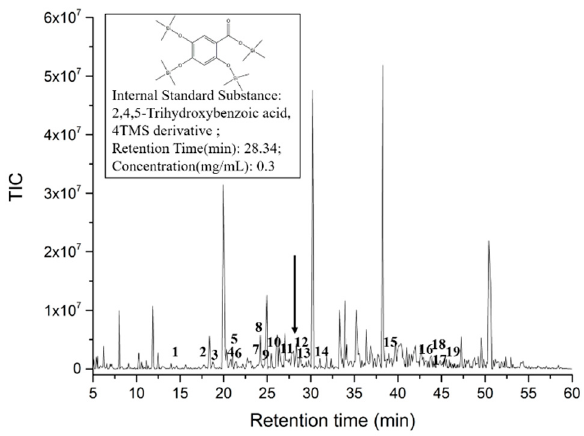
Figure 1. Total intensity chromatogram (TIC) images of SAVEP.